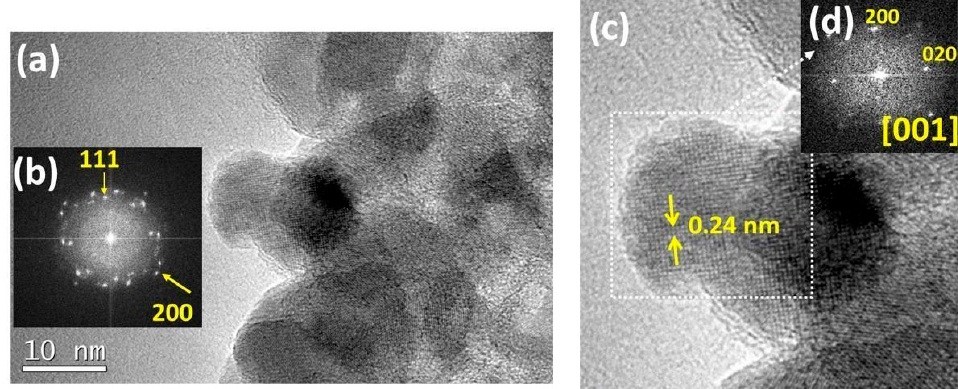
Figure 11. ( a ) TEM image of Zn-blende CoO nanoparticles and ( b ) corresponding fast Fourier transform (FFT) pattern. ( c ) HRTEM images and ( d ) corresponding FFT pattern of a representative nanocrystal along [001] zone axis.